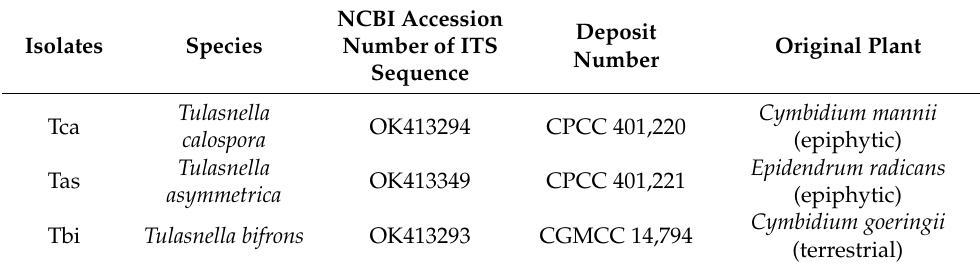
Table 1. Sources of the orchid species from which the samples were collected. Isolates Species